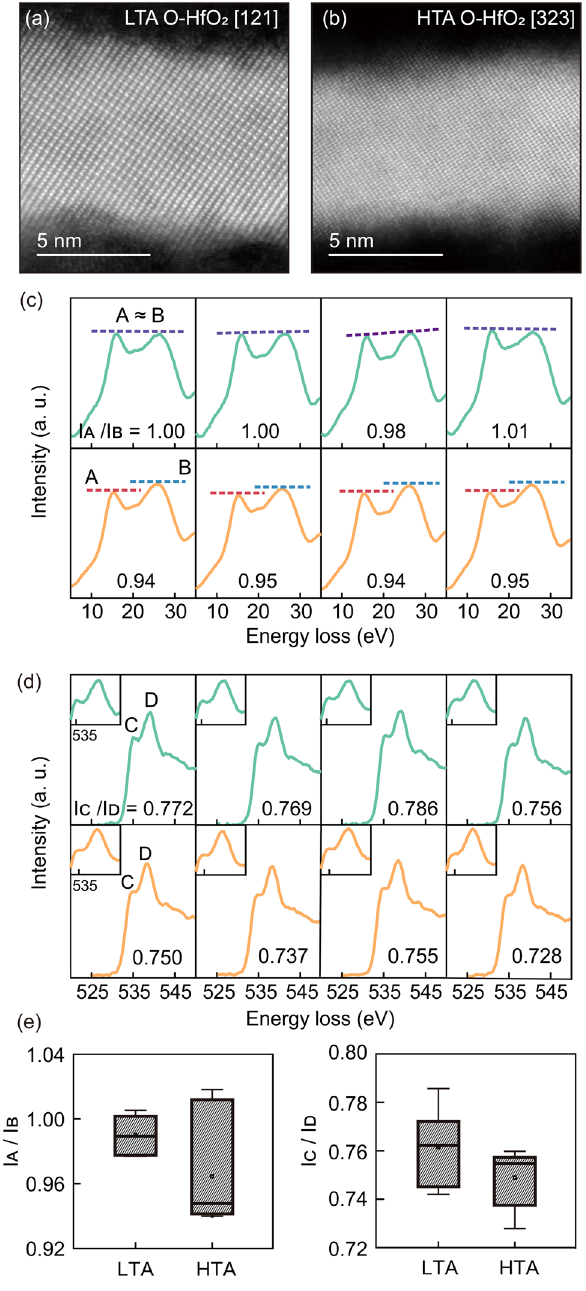
Figure 2. Cross-sectional images of orthorhombic HfO 2 using the high-resolution scanning transmission electron microscopy ( a ) along zone axis [121] of the LTA film and ( b ) along zone axis [323] of the HTA film. ( c ) Valence electron energy-loss spectroscopy results and ( d ) O K edges showing different intensity ratio of peaks in the LTA (green) and HTA (orange) films. Insets show the double-peaked shape of the O K edges. ( e ) Box plots of the intensity ratios of peak A, B (left), and C, D